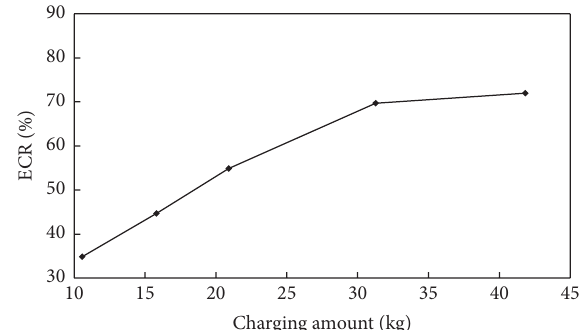
Figure 4: Relationship of casting ratio with charging amount.